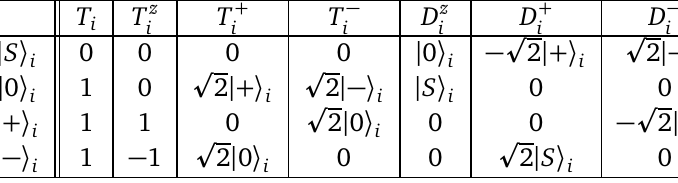
(cid:126) T 2 and T z are diagonal in this basis, we quote only the corresponding i i